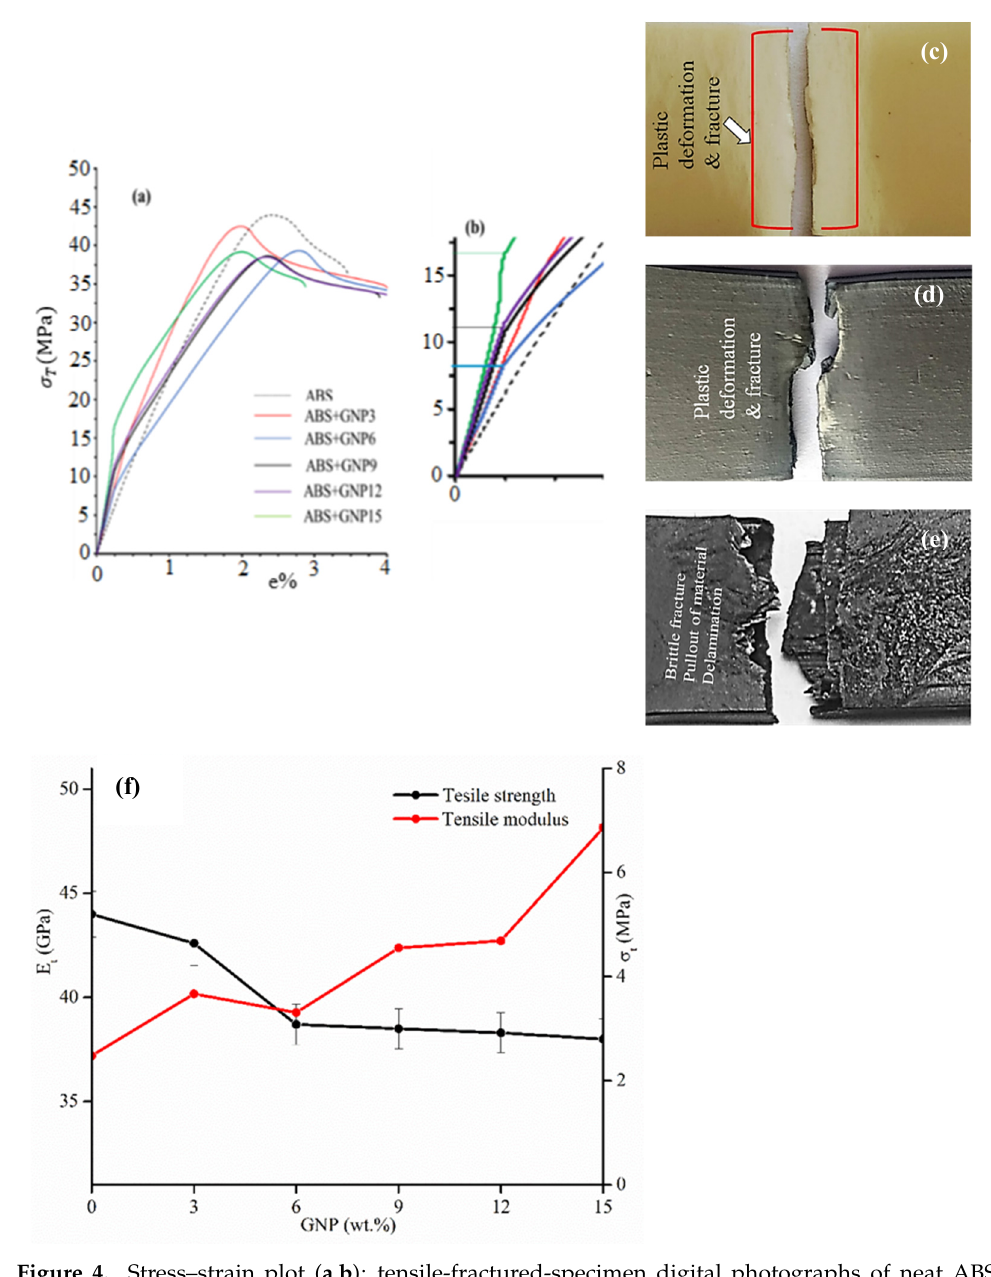
Figure 4. Stress–strain plot ( a , b ); tensile-fractured-specimen digital photographs of neat ABS, ABS+GNP3, and ABS+GNP15 nanocomposites ( c – e ); ( f ) tensile strength and Young’s modulus versus GNP concentrations.